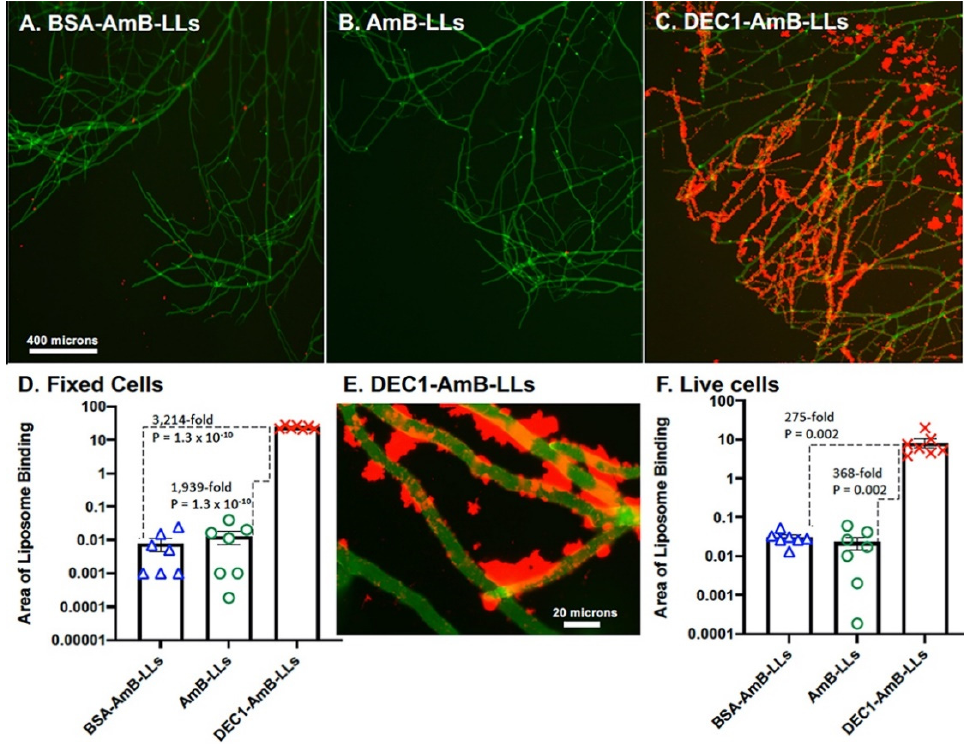
Figure 2. Dectin-1-targeted liposomes bind efficiently to R. delemar hyphae. ( A – C ) Representative fluorescence images of R. delemar hyphae (5 × magnification) are shown. Hyphae grown on an agar surface were fixed and either treated with BSA-AmB-LLs ( A ), AmB-LLs ( B ), or DEC1-AmB-LLs ( C ). ( D ) The area of red liposome binding (log 10 ) for fixed cells was quantified as shown (N = 7). ( E ) A fluorescence image of DEC1-AmB-LLs binding to fixed R. delemar hyphae at 63× magnification is shown. ( F ) The area of red liposome binding (log 10 ) for live hyphae was quantified as shown (N = 7). Standard errors and p -values are included. Size bars indicate 400 and 20 micron scales for the 5 × and 63 × images,